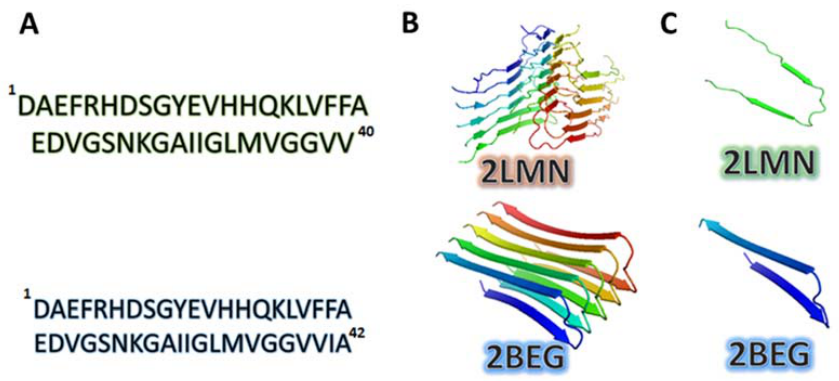
Figure 1. 3D structure of A β 1 ‐ 40 and A β 1 ‐ 42. ( A ) Amino acid sequences for A β 1 ‐ 40 and A β 1 ‐ 42; ( B ) ( B ) 3D structure of A β 1-40 hexamer (PDB 2LMN) and A β 1-42 pentamer (PDB 2BGE); ( C ) 3D 3D structure of A β 1 ‐ 40 hexamer (PDB 2LMN) and A β 1 ‐ 42 pentamer (PDB 2BGE); ( C ) 3D structure of